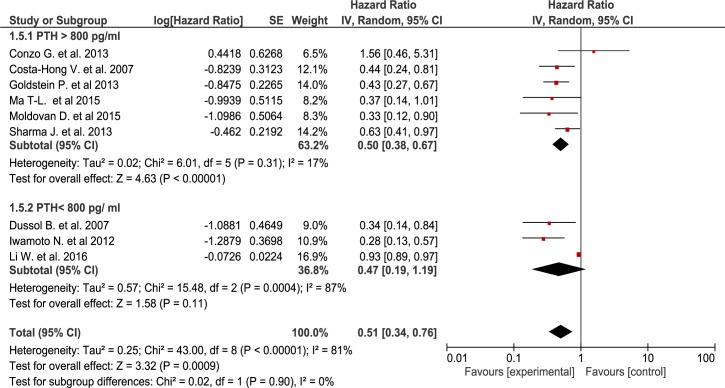
Subgroup analysis for low and high PTH value at baseline.